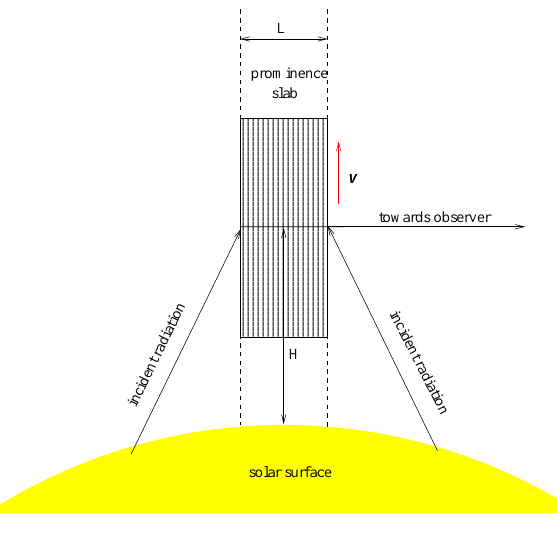
Fig. 1. Schematic representation of the 1-D plane-parallel promi- nence slab of geometrical width L , altitude H above the solar sur- face, moving radially at a velocity V